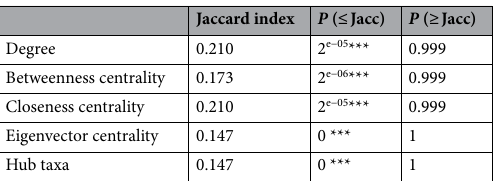
Table 2. Jaccard index for pathogen-free and R. helvetica infection